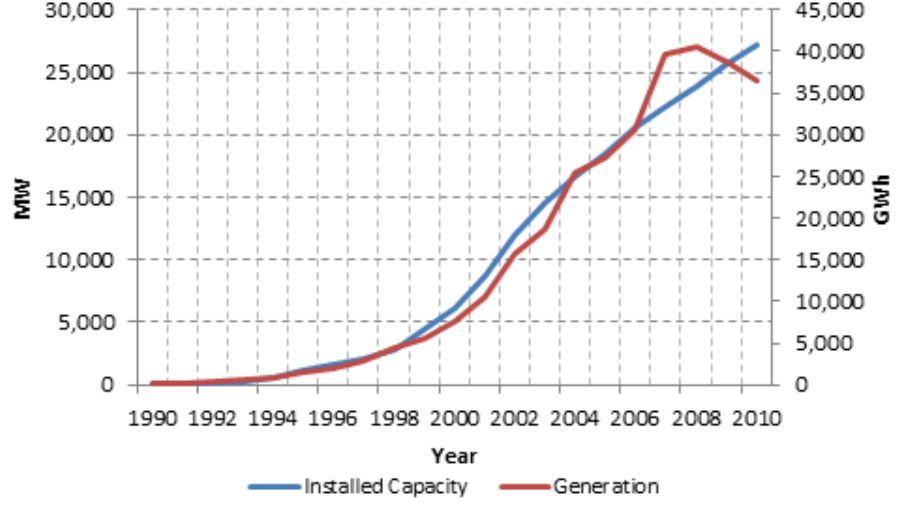
Figure 1. Wind power capacity and generation in